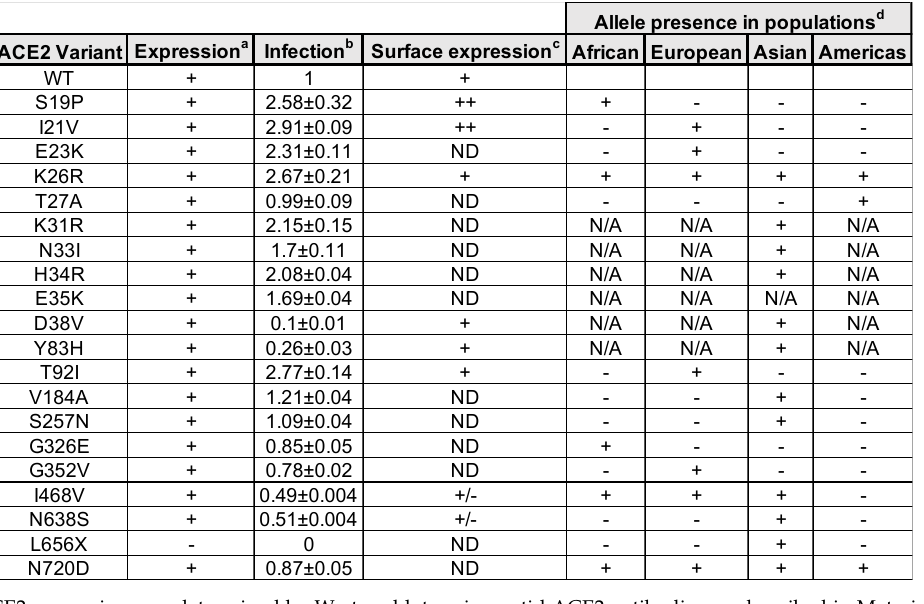
Table 2. Phenotypes of hACE2 proteins.